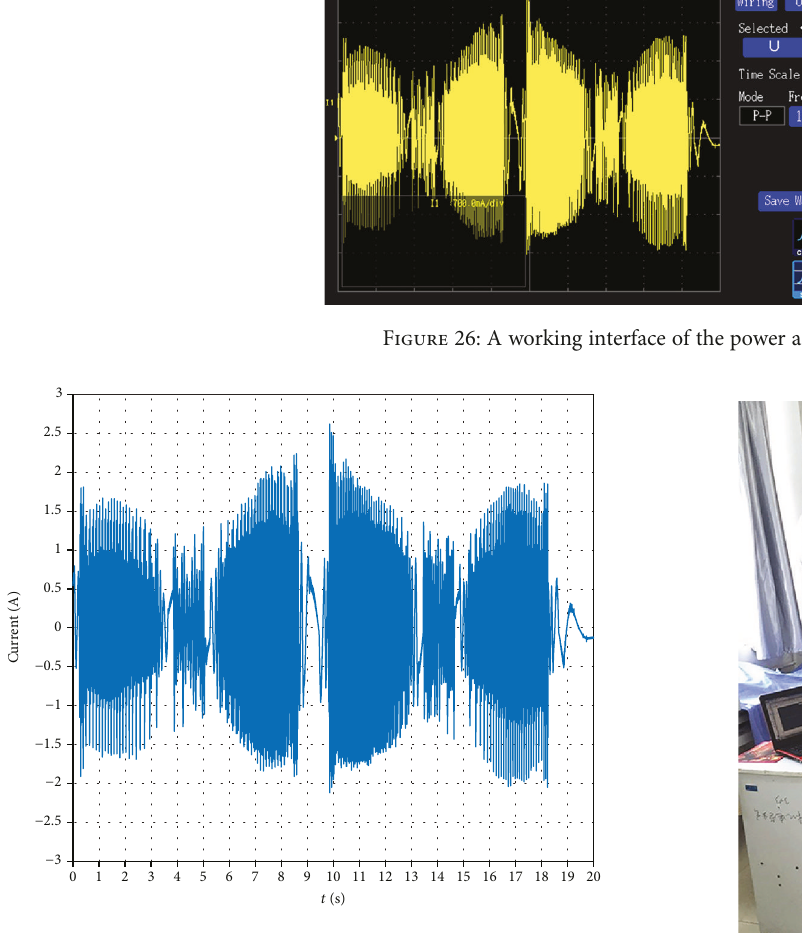
Figure 27: The working currents of the motor for the varus/valgus rehabilitation motion (from -20 ° to +20 ° ).